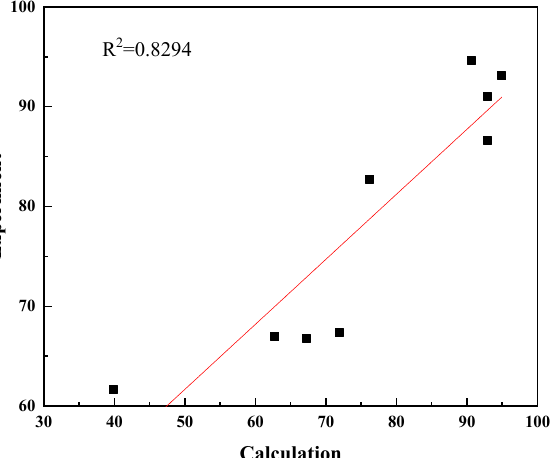
Figure 7. Predicted and experimental values of arsenic volatilization during SH combustion.